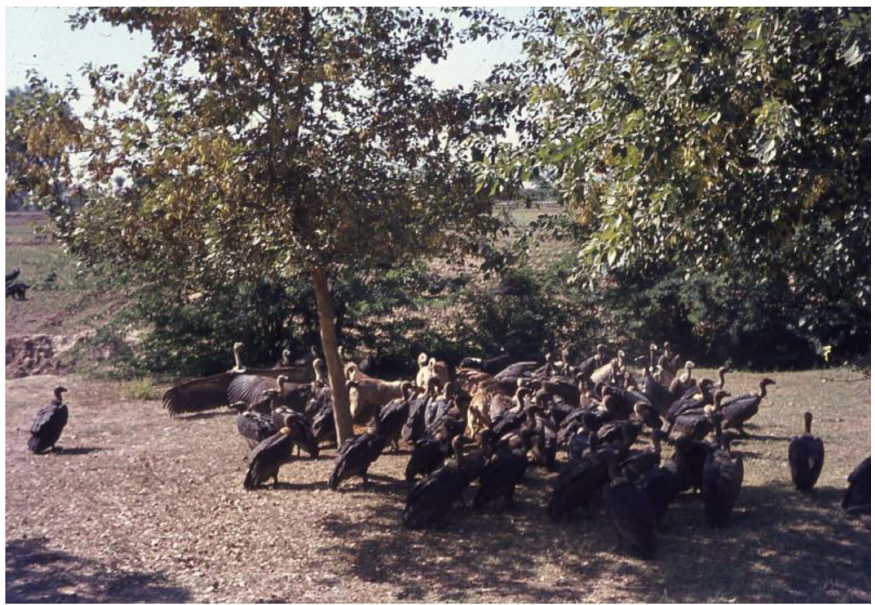
Figure 2. Carcasses of animals were in distant past intensively frequented by vultures. They must have been regular companions of men when feeding on slaughtered animals. (Picture from rural India, 1968, Helmut